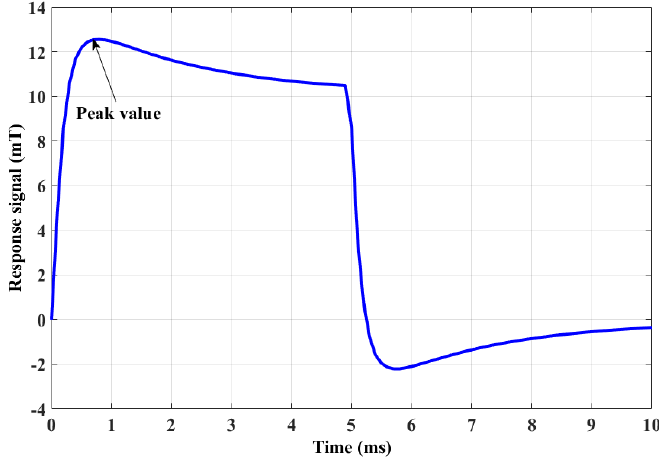
Figure 2. PECT response signal.